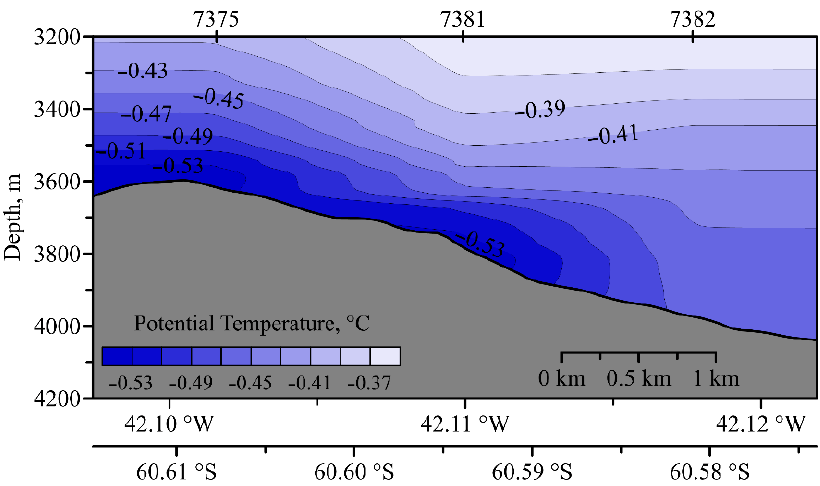
Figure 8. Potential temperature distribution over the downslope section of the Orkney Passage.